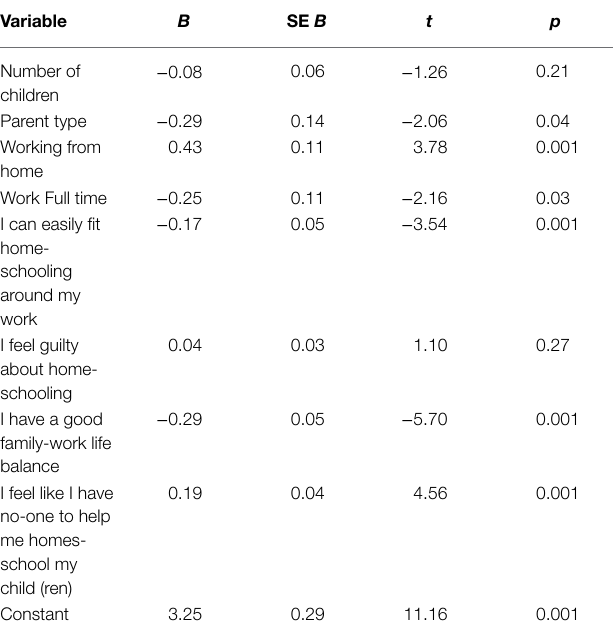
TABLE 3 | Summary of linear regression analyses for variables predicting parent stress.